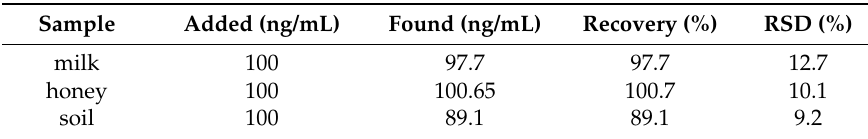
Table 2. Determination of abrin in spiked samples ( n =